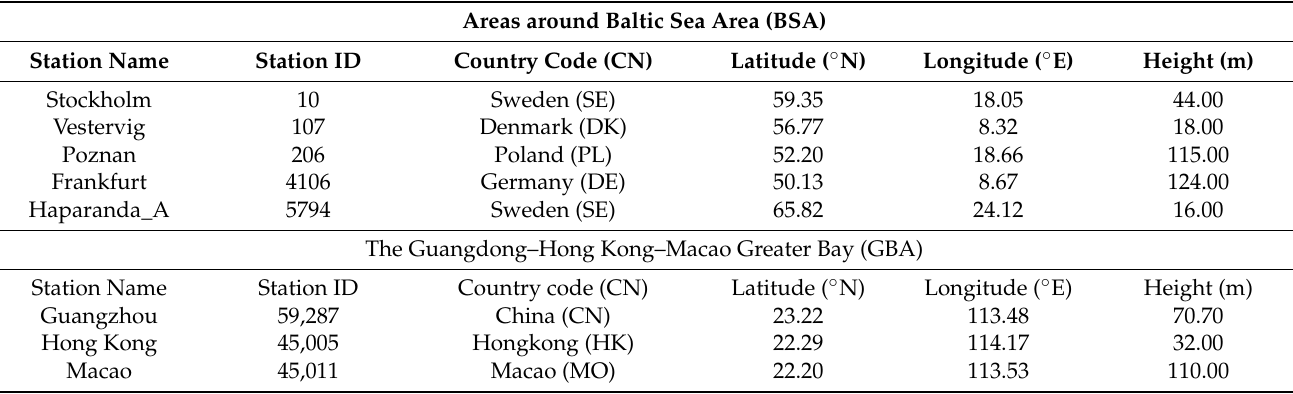
Table 2. Data processing information of the representative stations in areas around the Baltic Sea area.